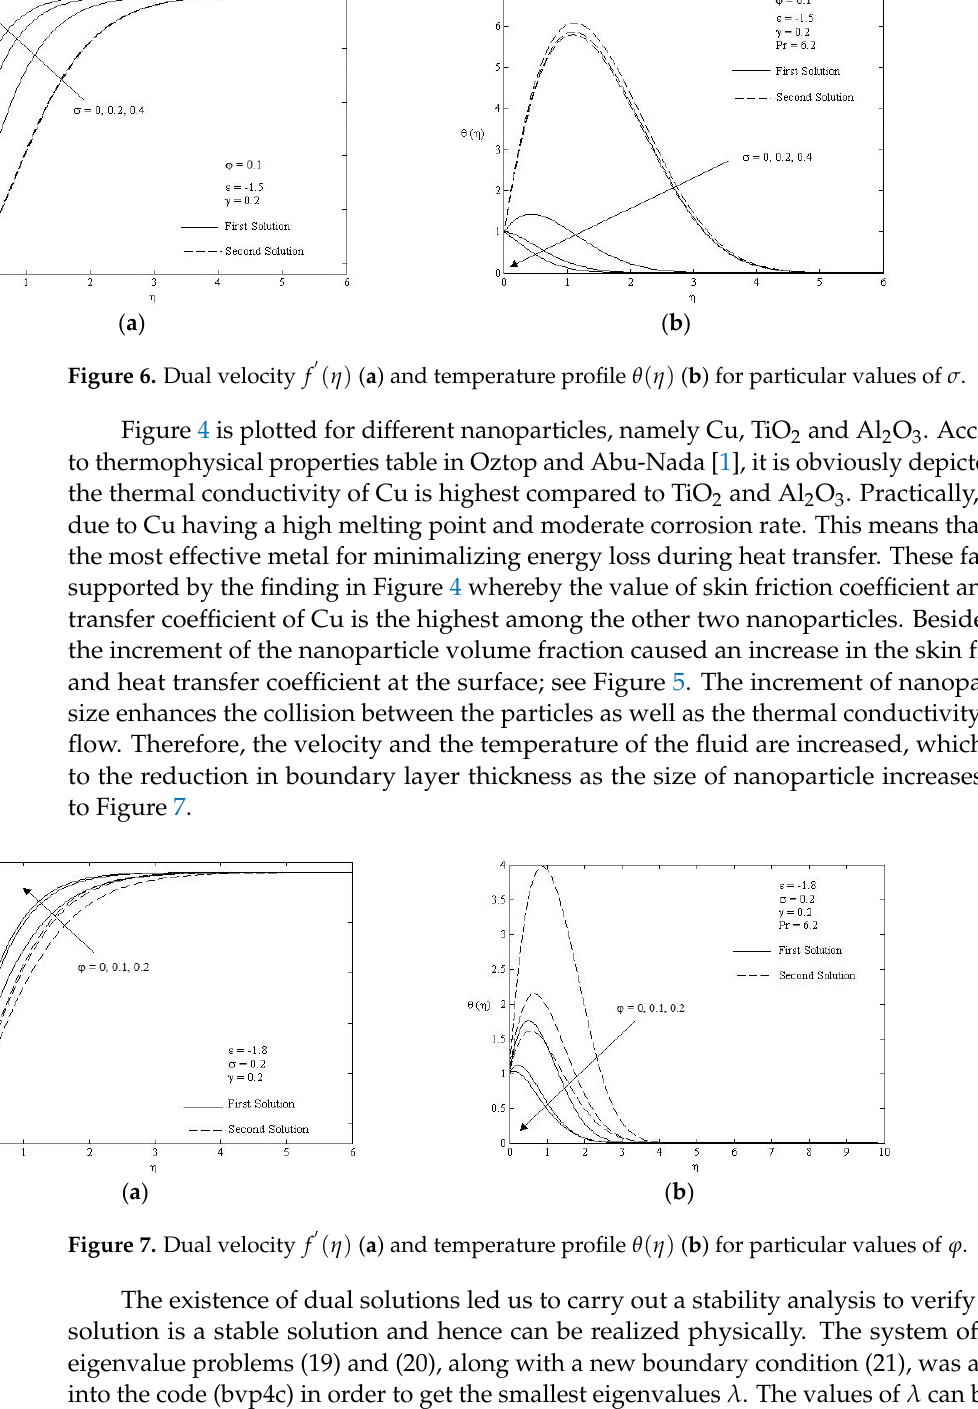
Figure 5. Skin friction 𝑓 (cid:4593)(cid:4593) (cid:4666) 0 (cid:4667) ( a ) and heat transfer coefficient (cid:3398)𝜃 (cid:4593) (cid:4666) 0 (cid:4667) ( b ) vs. 𝜀 for particular val ‐ ues of 𝜑 .